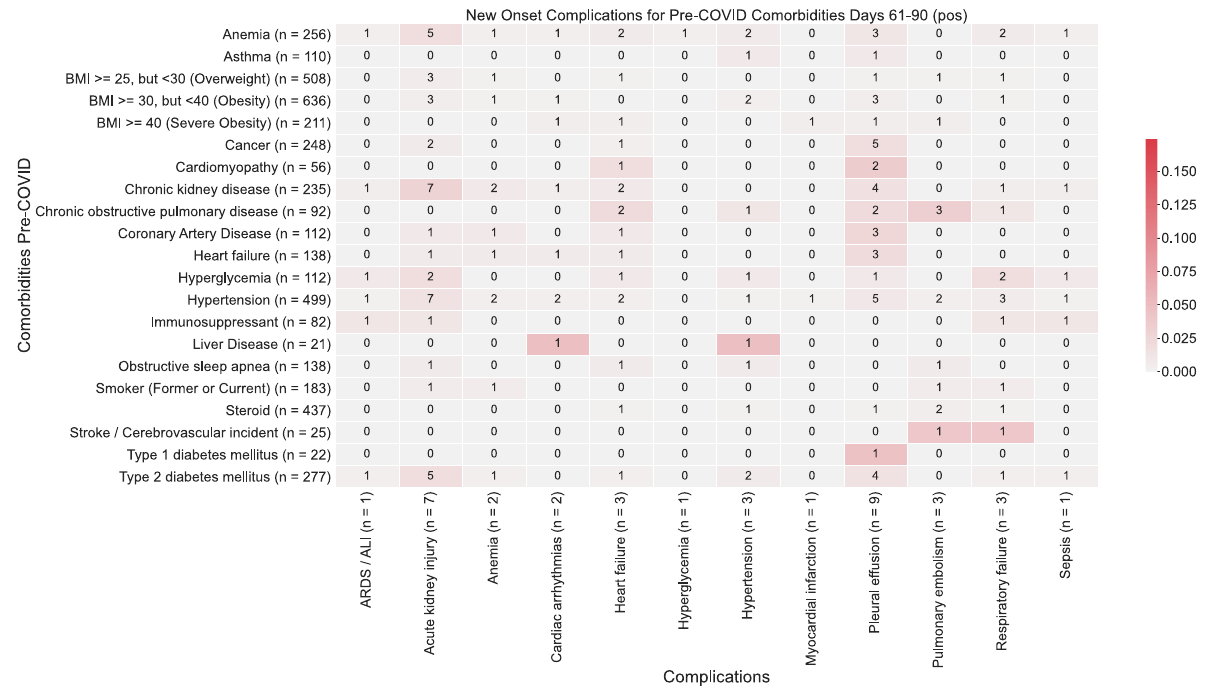
Fig. 4 Heatmap showing associations between comorbidities and late-onset complications (61 – 90 days post-PCR) in COVID-19 patients. The number in each (comorbidity, complication) cell corresponds to the number of patients with the comorbidity that had the complication for the fi rst time in the time window (61 – 90 days). The color of each (comorbidity, complication) pair corresponds to (number of patients with the comorbidity that had the complication for the fi rst time in the time window (61 – 90 days))/(total number of patients with the comorbidity). Darker shades of red correspond to higher rates of complications, and lighter shades of red correspond to lower rates of complications. A patient is determined to have comorbidity if it is recorded in their clinical notes with positive sentiment any time before their fi rst positive PCR test. For each comorbidity row and for each complication column, the number of patients is shown in